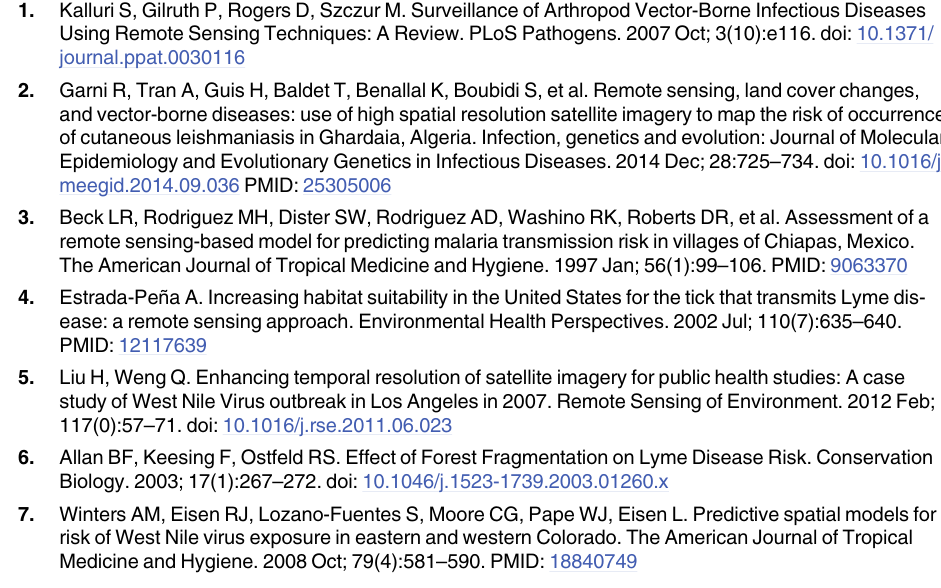
S1 Fig. Hydrography of the State of São Paulo. The uniform distribution of water sources is evident throughout the state. (TIF) S2 Fig. Spectral reflectance information for the endmembers selected. Spectral reflectance for the Atlantic vegetation (green line), sugarcane crops (red line) and substrates (blue line) endmembers. (TIFF) S3 Fig. Root mean square (RMS) difference map between the observed and predicted mix- tures. White colors represents misfit values and black colors indicate that the endmembers chosen are well characterize.